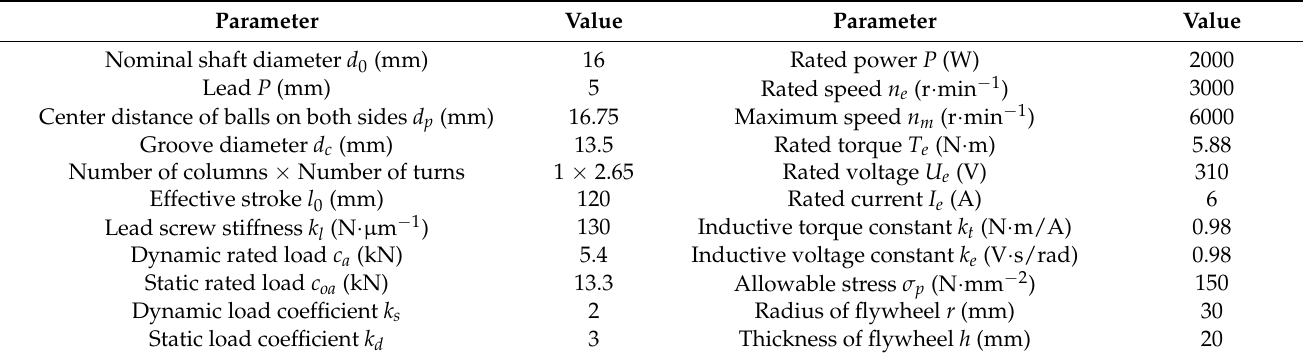
Table 5. Parameters of the key components.